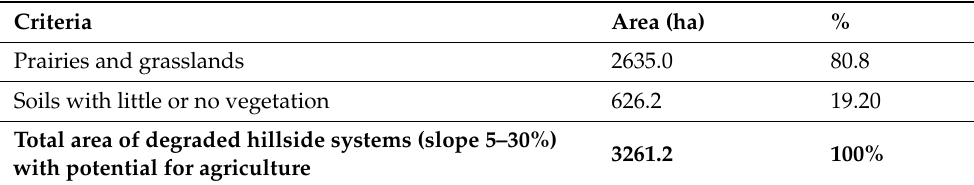
Table 7. Coverages of degraded hillside systems (slope 5–30%) with potential for agriculture after applying all the criteria described